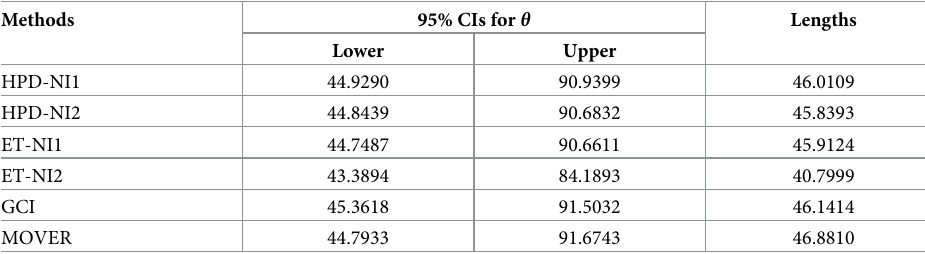
Table 6. 95%CIs for the weekly average natural rainfall in northern